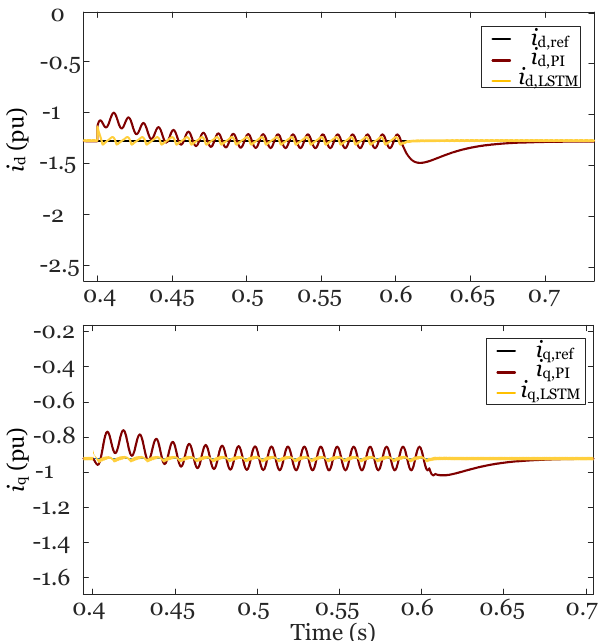
Figure 13. Controller response to a double phase-ground fault at PCC.